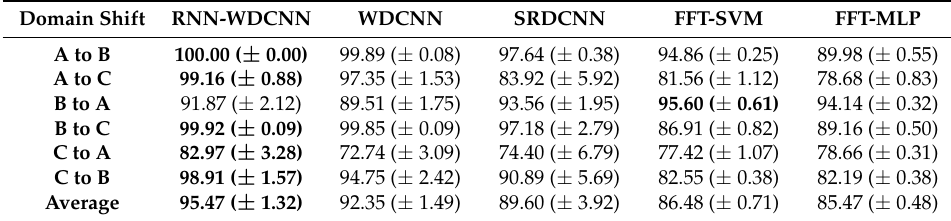
Table 8. F1 scores of the models considered in this work (as a percentage) for the domain adaptation task considered in scenario 1 (best values are highlighted in bold).